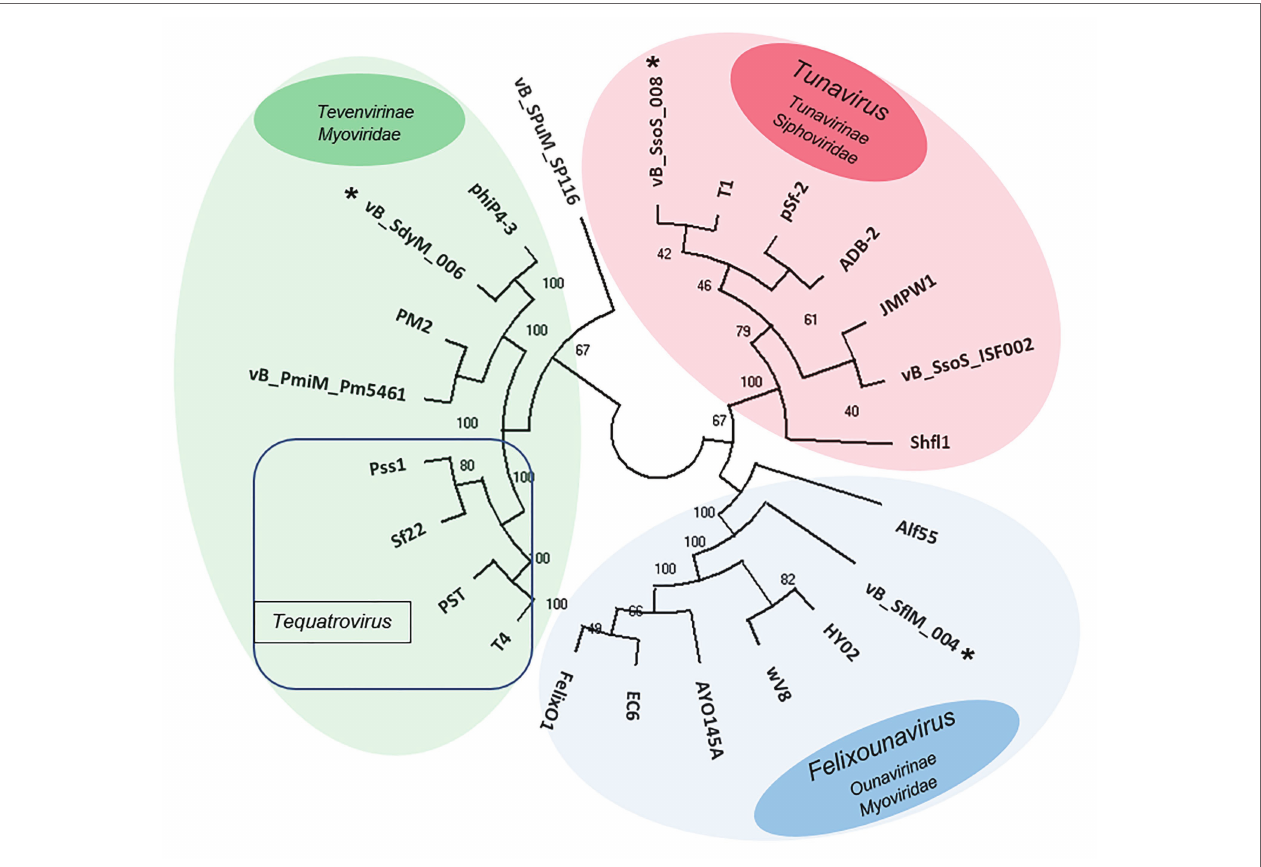
FIGURE 7 | Unweighted pair group method with arithmetic mean (UPGMA) tree phylogenic analysis of the major capsids of phages vB _SflM_004, vB_SdyM_006, and vB_SsoS_008. The tree was rooted using the major capsid of Salmonella enterica serovar Pullorum lytic phage vB_SPuM_SP116 (Bao et al., 2019) as the out- group. The bootstrap percentages are shown next to each node. Phage groups as defined in the ICTV virus taxonomy (https://talk.ictvonline.org/taxonomy/) release are represented by different